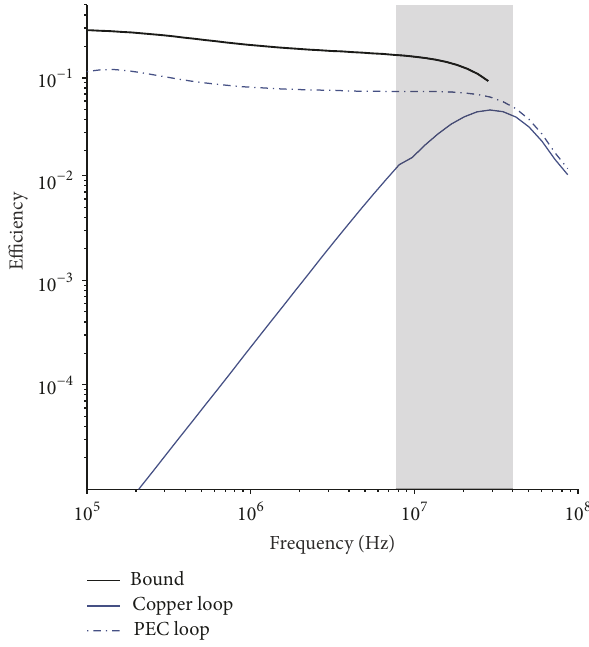
Figure 3: The bound on efficiency for the given receiver is shown with a solid black curve. Due to the finite conductivity of copper, the efficiency of the loop (solid blue) is much lower than the bound. To achieve an efficiency as close to the bound as possible, the device should operate in the shaded frequency